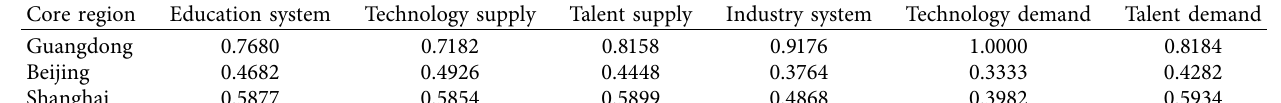
Table 3: Evaluated development levels of the two systems.